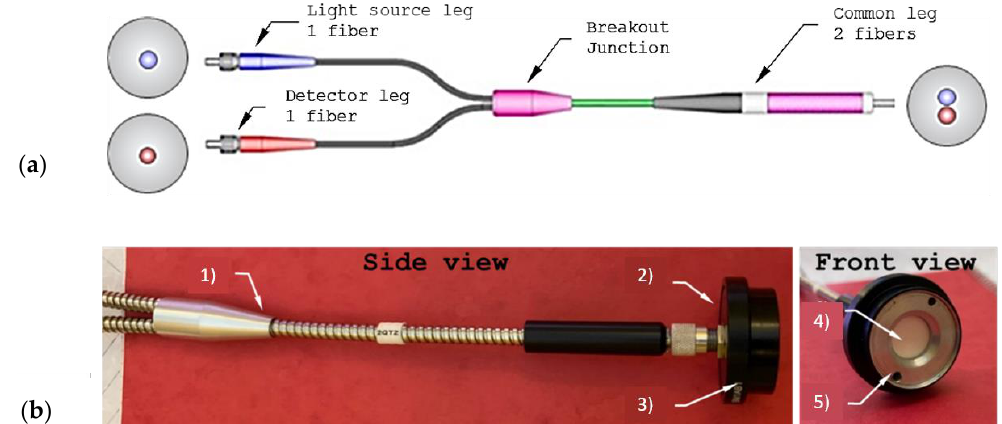
Figure 6. ( a ) Concept design of the proposed bifurcated fibers. ( b ) Realized prototype: (1) optical fiber cable Y-shaped, (2) fiber adapter plate, (3) optic mount, (4) ceramic disk, (5) stainless steel ring. Reprinted with permission from Elsevier from Ref. [59] (the figure is released under a Copyright Clearance Center’s RightsLink ® service, Copyright © 2022).